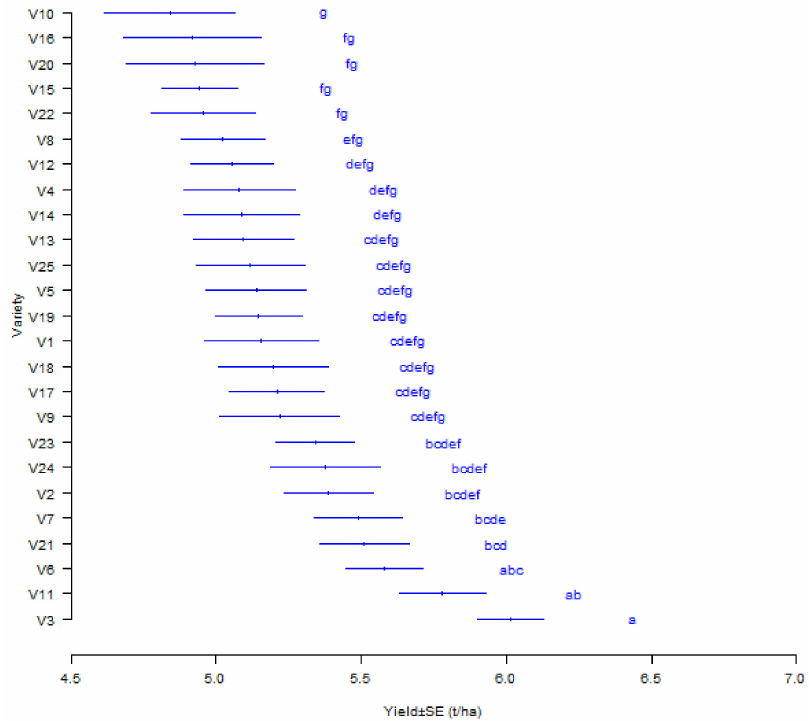
Figure 1. Specific yield performance of spring oat variety (Different letters between cultivars de- note significant differences Post-hoc LSD test, p < 0.05). V1—Some¸san; V2–Mure¸s;